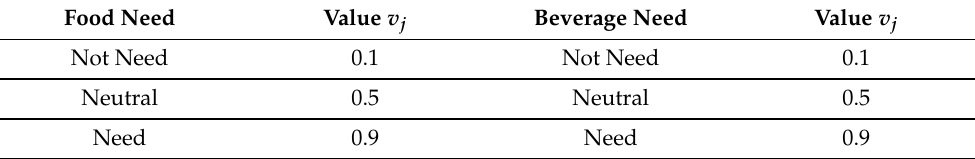
Table 2. Values for Socialization Features in a Dinner: “Food Need” and “Beverage Need”. Food Need Value v